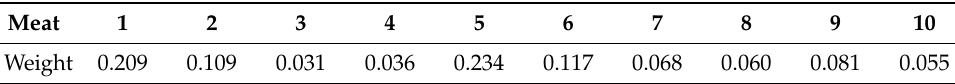
Table A4. Weight of each criterion for